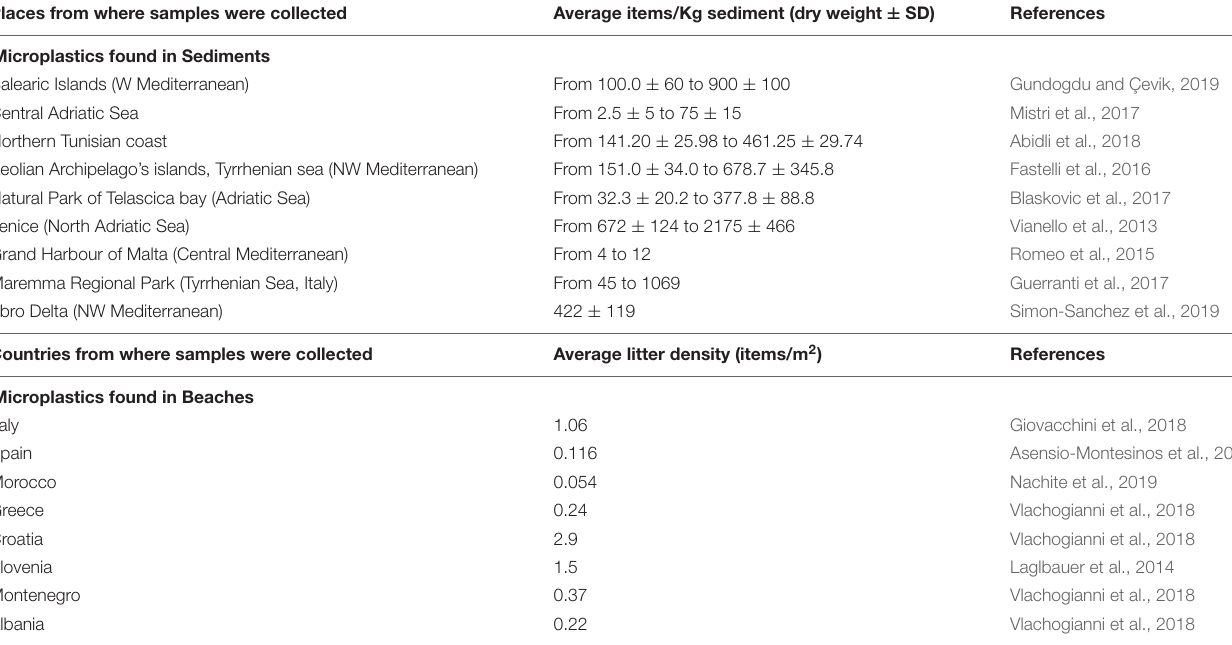
TABLE 2 | Microplastics found in sea sediments and beaches around the Mediterranean Sea. Places from where samples were